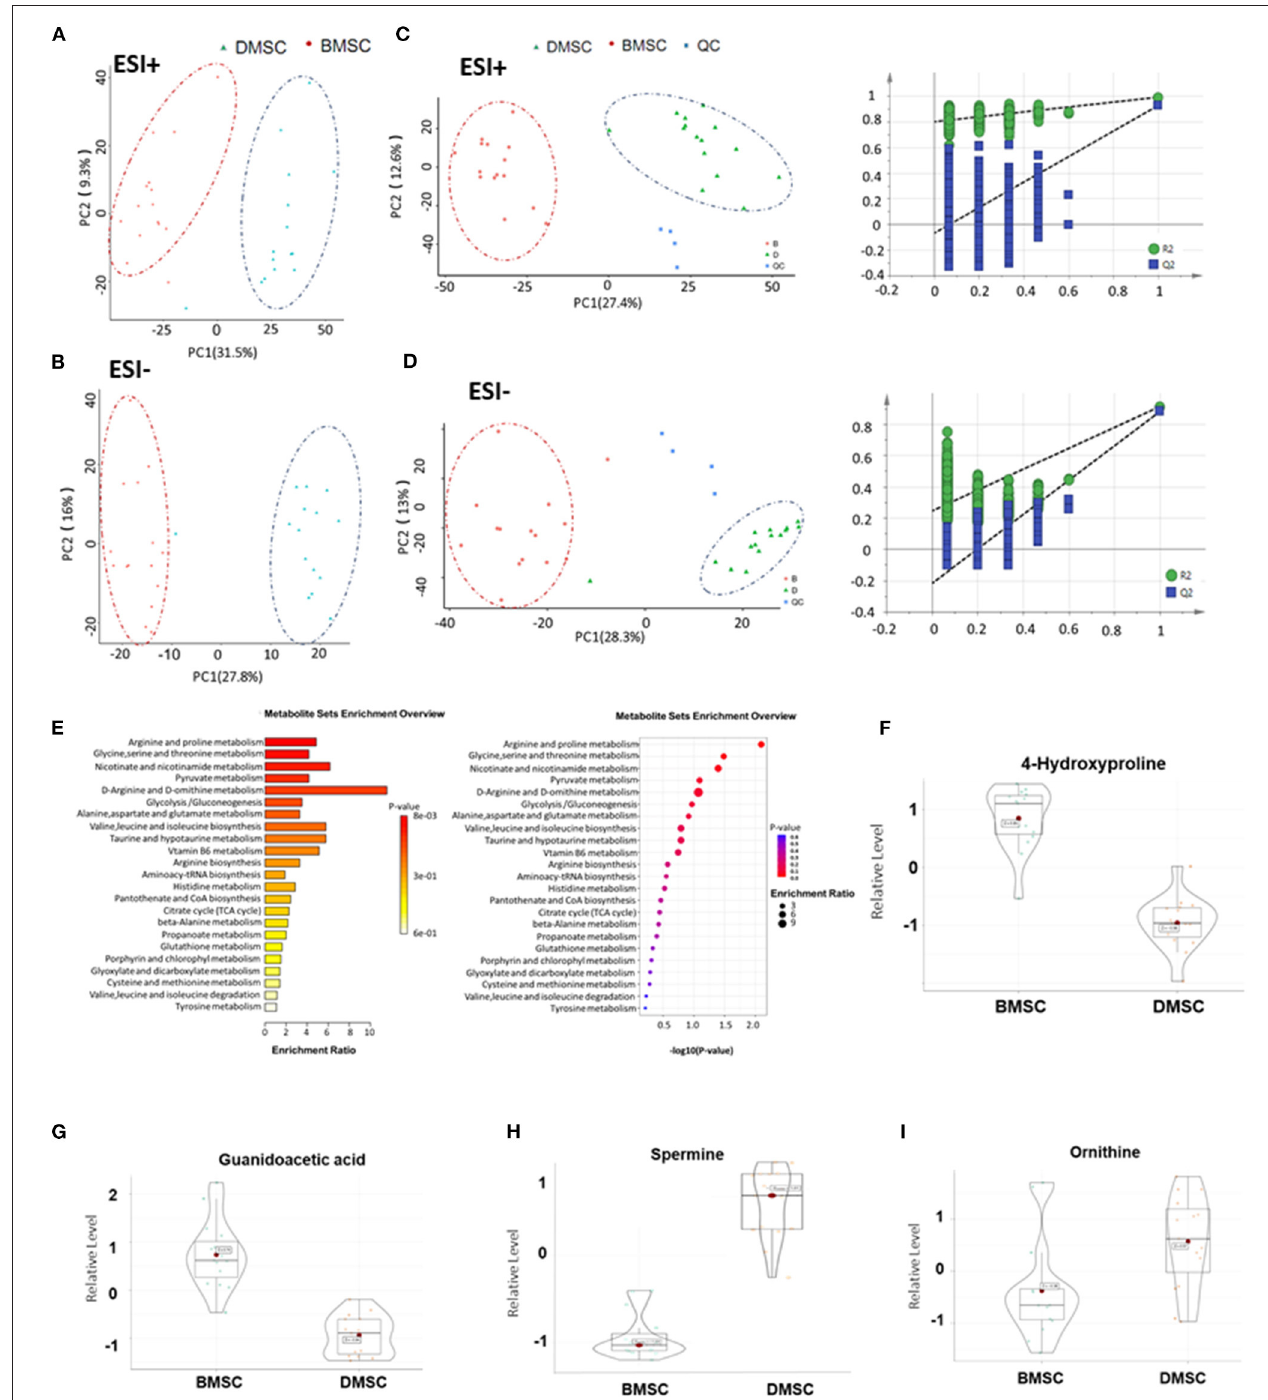
FIGURE 2 | Metabolic profiles of BMSCs and DMSCs. (A,B) Principal component analysis score plots for discriminating BMSCs and DMSCs in ESI + and ESI- modes. (C,D) PLS-DA plots and validation plots for discriminating BMSCs and DMSCs in ESI + and ESI- modes. (E) Column chart and bubble chart of KEGG enrichment analysis of all differential metabolites. (F–I) Metabolite profiles of different biomarkers between epithelial BMSCs and DMSCs. Each P -value was < 0.01. compared with the BMSC groups ( Figures 5C–E ). These results LVFS after DMSC and BMSC transplantation were significantly suggest that DMSC transplantation can significantly improve increased compared with the control group. However, LVEF and cardiac function post-MI partly via ODC-mediated ornithine LVFS in the BMSC + ODC group were significantly increased